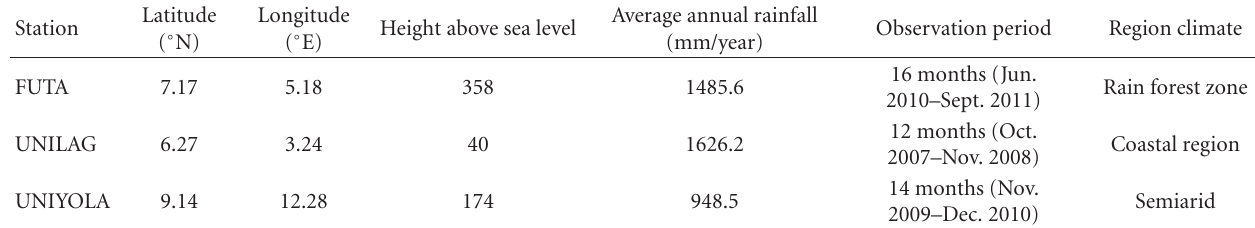
Table 1: Site characteristics of the study locations.